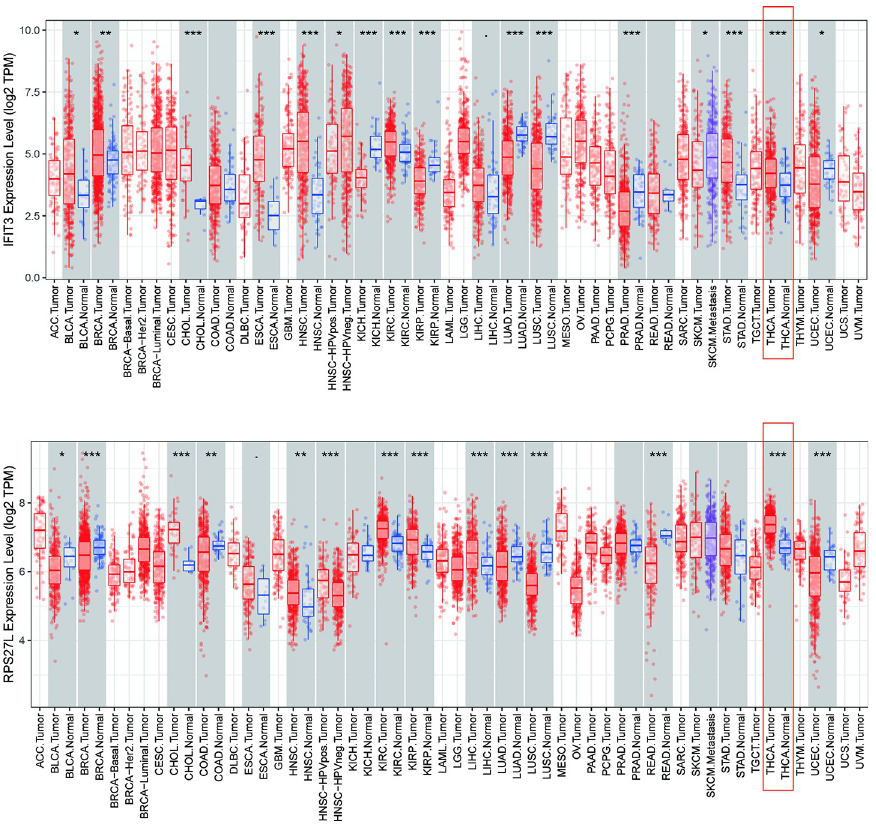
Fig 9. The expression of the two predictive genes in cancers. Data were from the TIMER database. p � < 0.05; p �� < 0.01; p ��� < 0.001.